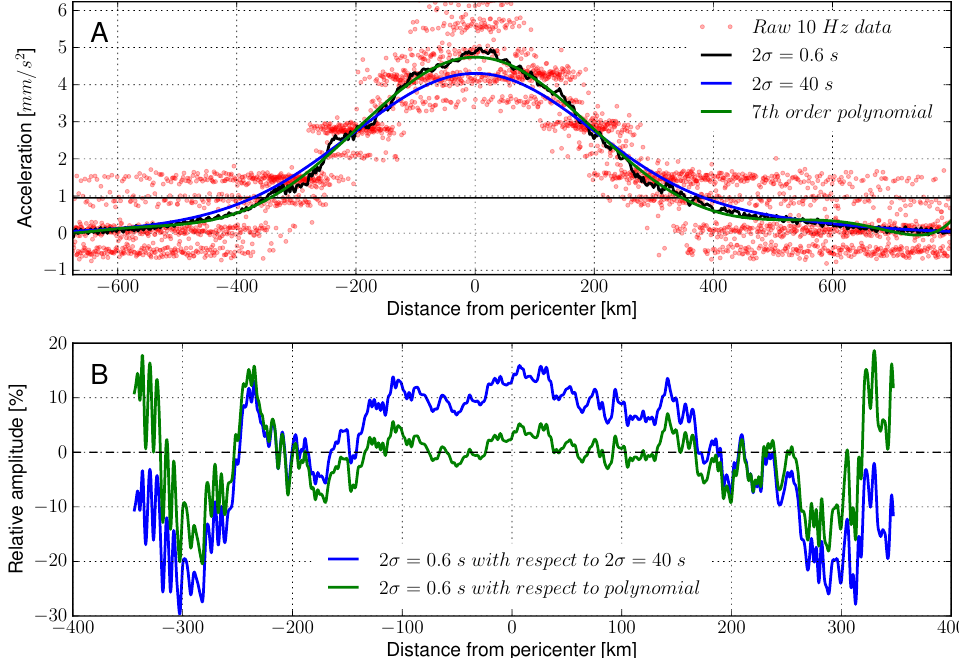
Figure 2. Semi-raw and filtered acceleration and its relative perturbations during pass number 42 as functions of the distance from the pericenter. ( A ) Semi-raw 10 Hz acceleration data (red), semi-raw data smoothed with a Gaussian filter of 2 σ = 0.6 s (black) and 2 σ = 40 s (blue), and seventh-order polynomial fit to the semi-raw data (green). The horizontal black line indicates 20% of the maximum acceleration. ( B ) The relative perturbations are estimated by removing the respective background acceleration and then normalizing the result with respect to the background. Note that applying the 2 σ = 40 s Gaussian filter introduces a bias near the